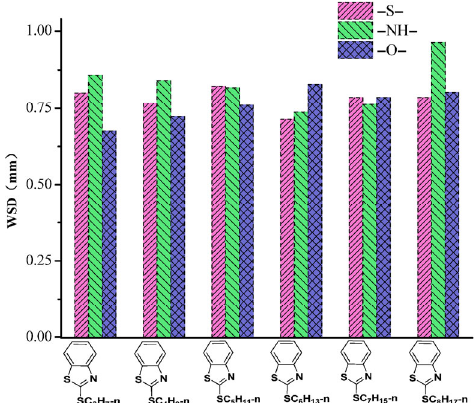
Fig. 14 The wear scar width of each steel ball when lubricating with thiobenzothiazole compounds and their isosteres in bis(2- ethylhexyl)